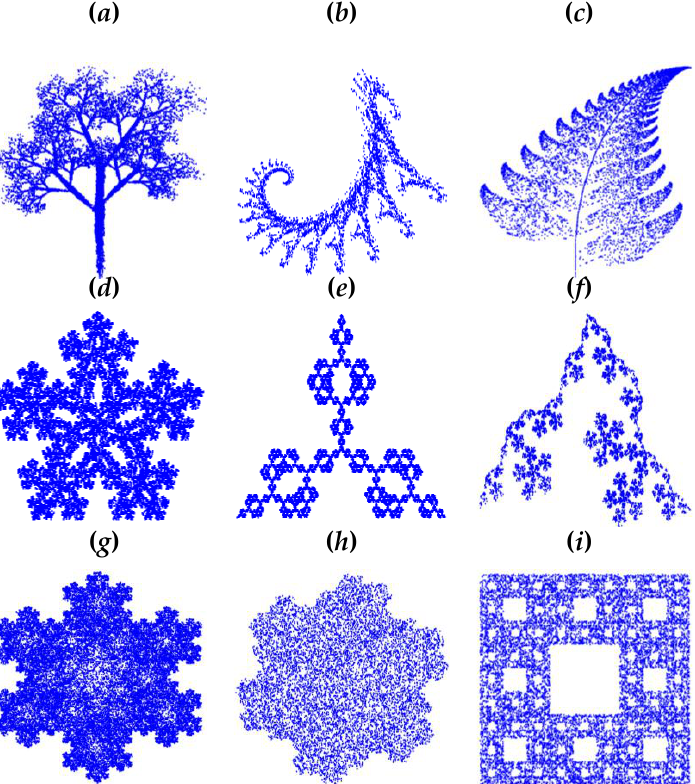
Figure 4. Nine point-clouds showing some well-known fractals: ( a ) tree; ( b ) seahorse; ( c ) fern leaf; ( d – h ) snowflakes; ( i ) the Sierpinski Carpet. Reprinted with permission from ref. [72]. Copyright 2021 Fuji Technology Press Ltd. (Tokyo, Japan).